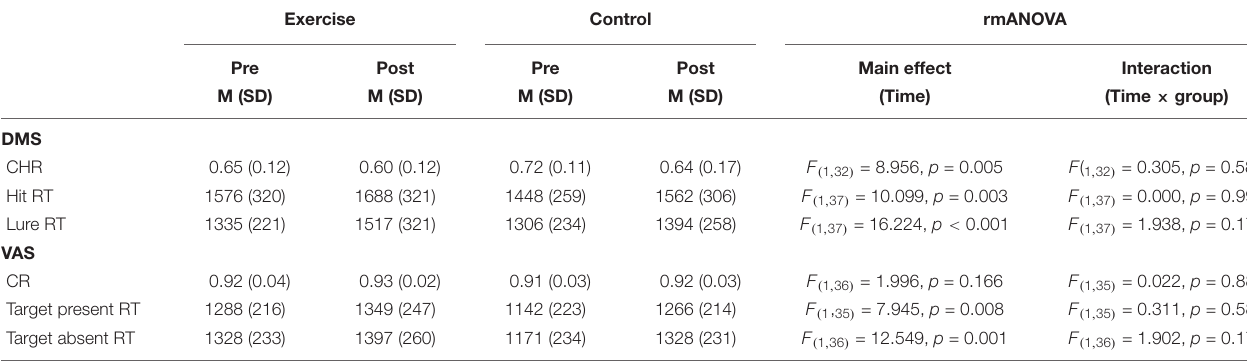
TABLE 3 | Group mean (SD) for behavioral performance values pre and post intervention. Exercise Control